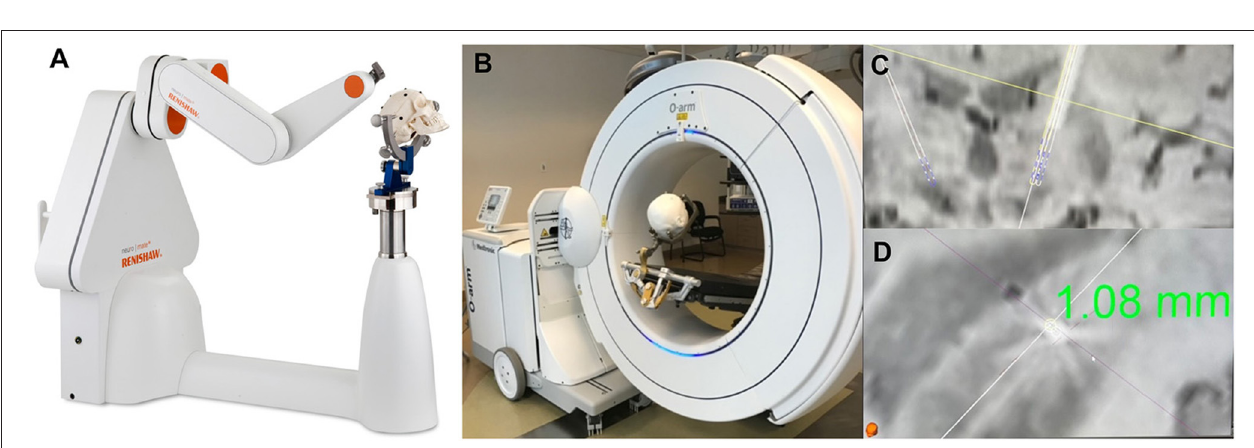
FIGURE 7 | Medtronic’s Percept TM . Examples of use cases of local field potentials from Percept PC TM programming interfaces using exemplary representative data. (A) shows a signal of interest such as average beta power trended over long periods to show fluctuations and times when a correlated symptom might present: “Symptomatic,” periods where a symptom might be absent: “Asymptomatic,” and periods where a patient may be over-treated and at risk of side effects: “Over-Treated,” and (B) shows use of signal viewed in real time to understand how it responds to amplitude titration during in clinic programming, in this example evoking a suppressive effect subsequent to a stimulation increase.